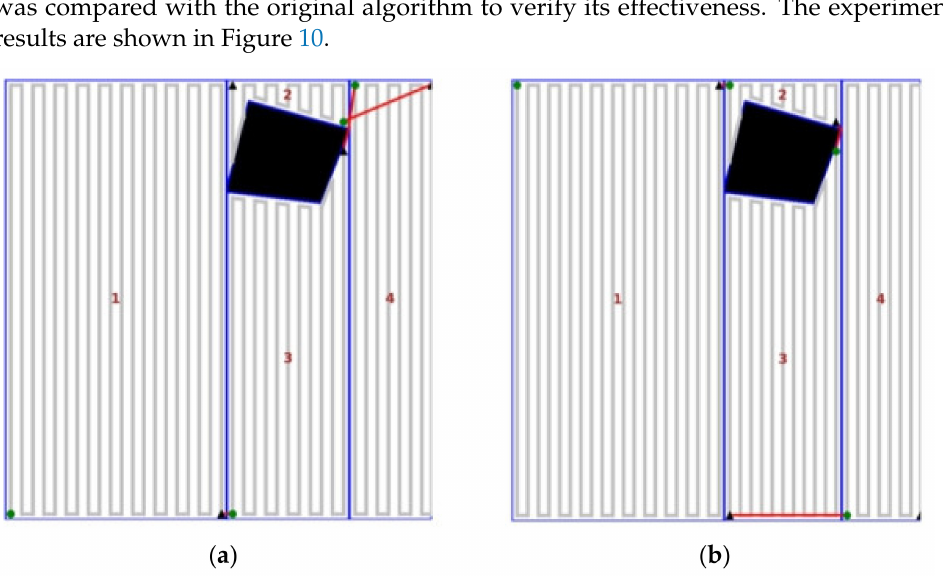
Figure 10. ( a ) Traditional CCPP; ( b ) improved CCPP. In the figure, the green dots represent the starting point of each sub-region and the black triangle represents the finishing point of each region. The red lines are the route connecting